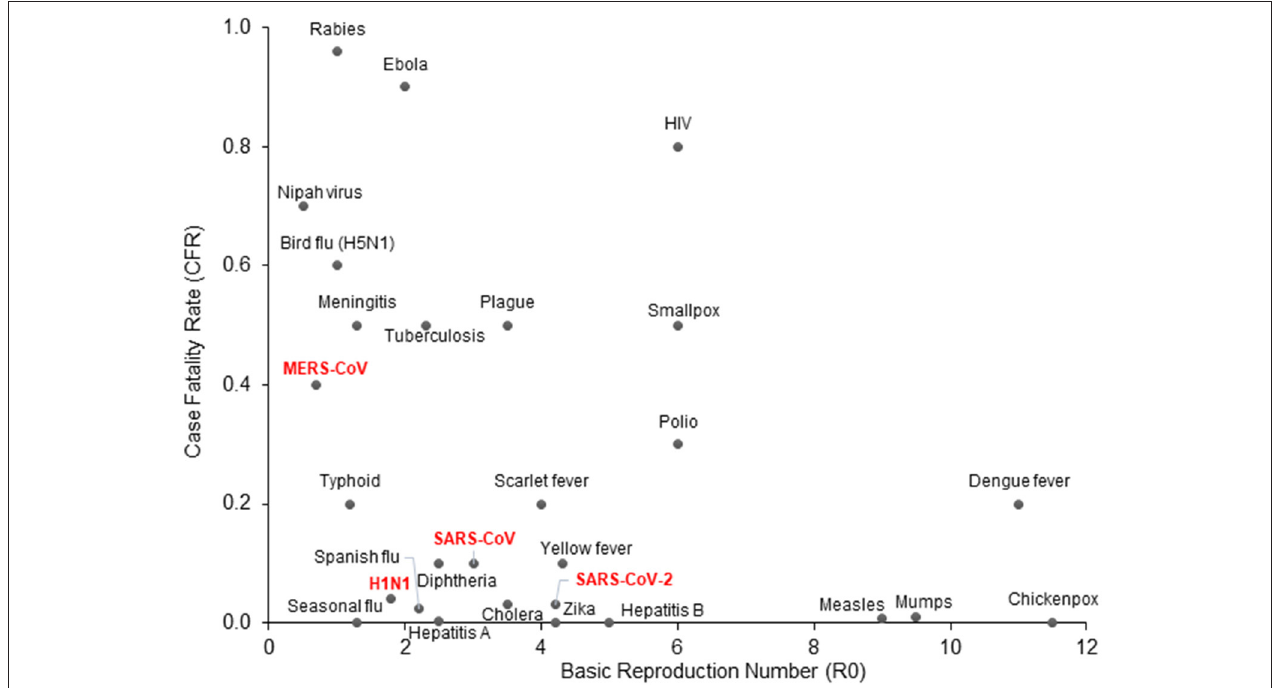
FIGURE 1 | COVID-19 epidemiologic characteristics compared to other prevalent infections. The Case Fatality Rate (CFR) for COVID-19 is estimated around 2–4% with some variation and a recent decline due to optimized supportive care. The Basic Reproduction Number (R0) shown on the x-axis is also an estimate from epidemiological data. SARS-CoV-2 is more contagious than SARS-CoV and MERS-CoV, which may be attributed to longer incubation periods and asymptomatic